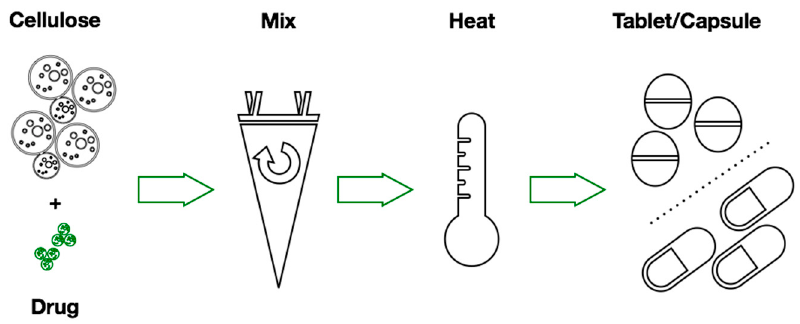
Figure 11. Process scheme for formulating profens with CLAD.